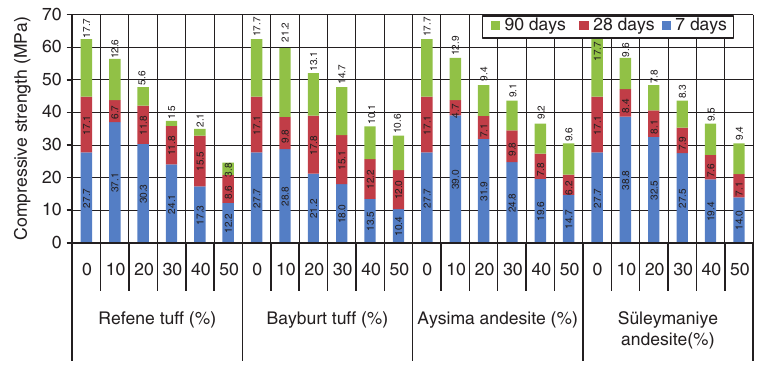
Figure 5 Compressive strength values of the samples at the end of 7, 28, and 90 days.